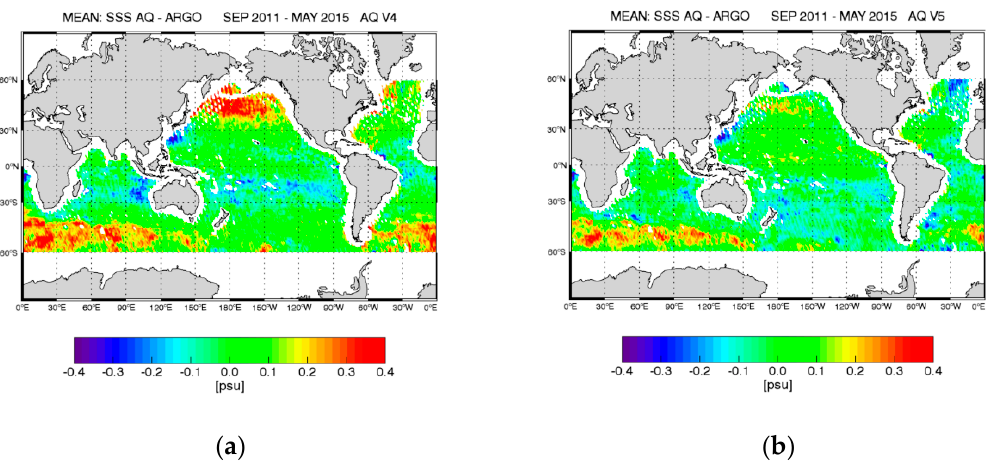
Figure 14. Average difference between Aquarius and Scripps ARGO over the time period September 2011–May 2015. Panel ( a ) is for the Version 4 release. Panel ( b ) is for the Version 5 release. For the comparison observations containing rain have been discarded (see Section 2.2.6).